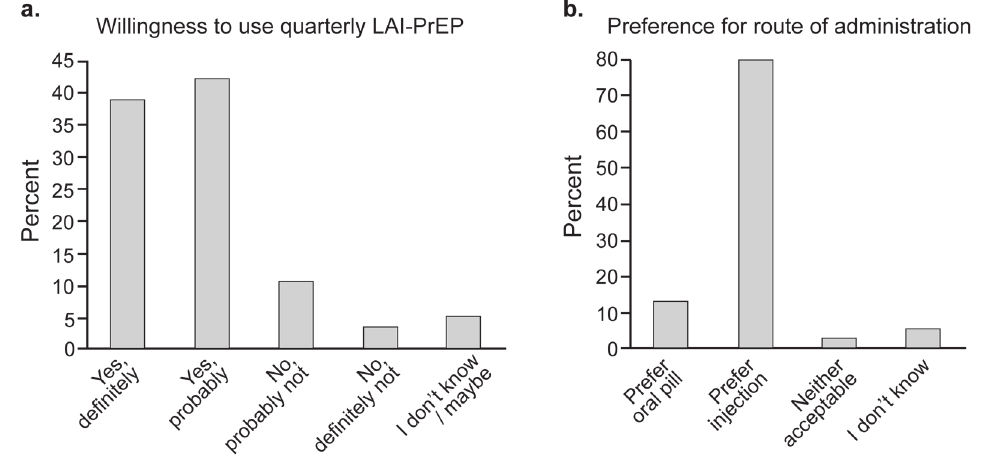
Fig. 1. Distribution of main